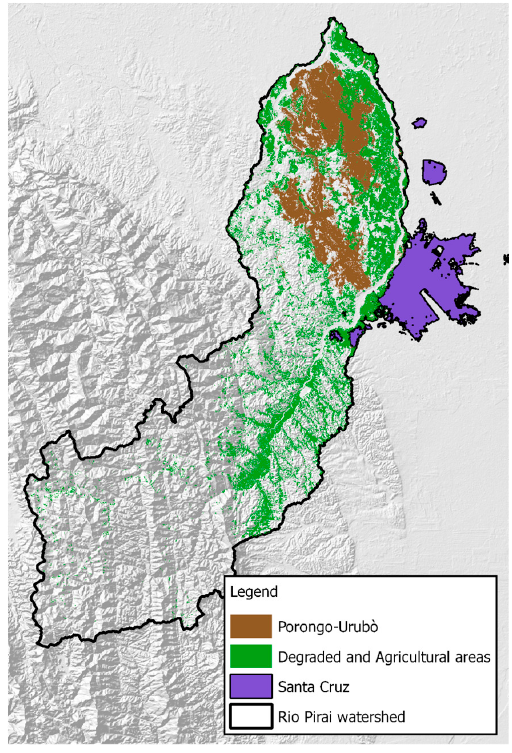
Figure 4. Land use units modeled in Scenarios 2–5.